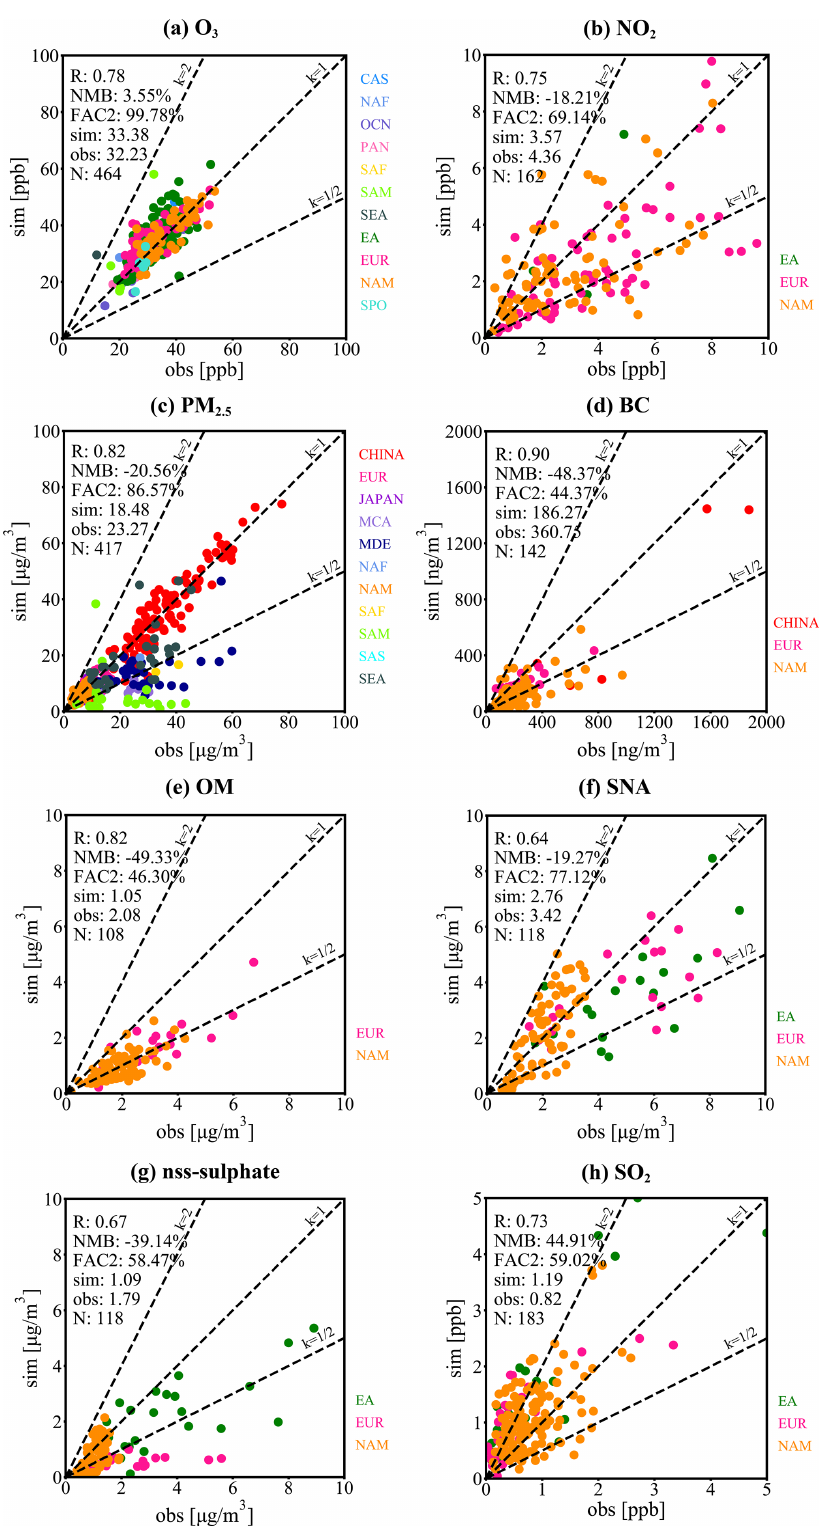
Figure 6. Scatterplots of simulated (sim) and observed (obs) annual mean concentrations. The black dotted lines are the 2 : 1, 1 : 1, and 1 : 2 reference lines from left to right. Different regions are plotted with circles in different